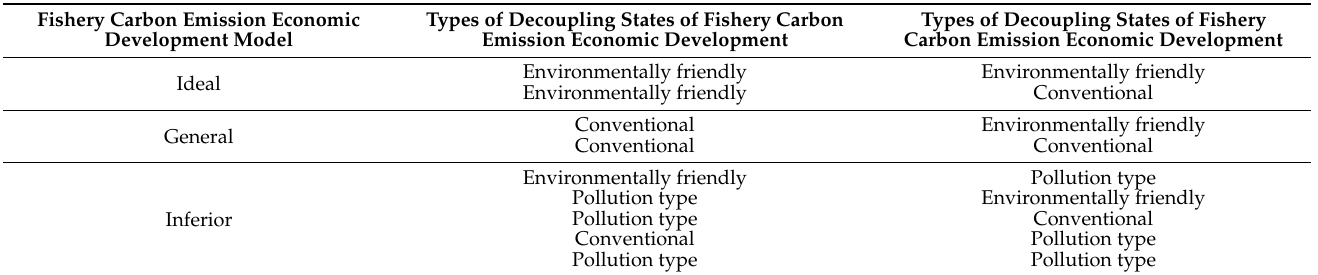
Table 17. Classification standard of fishery economic development